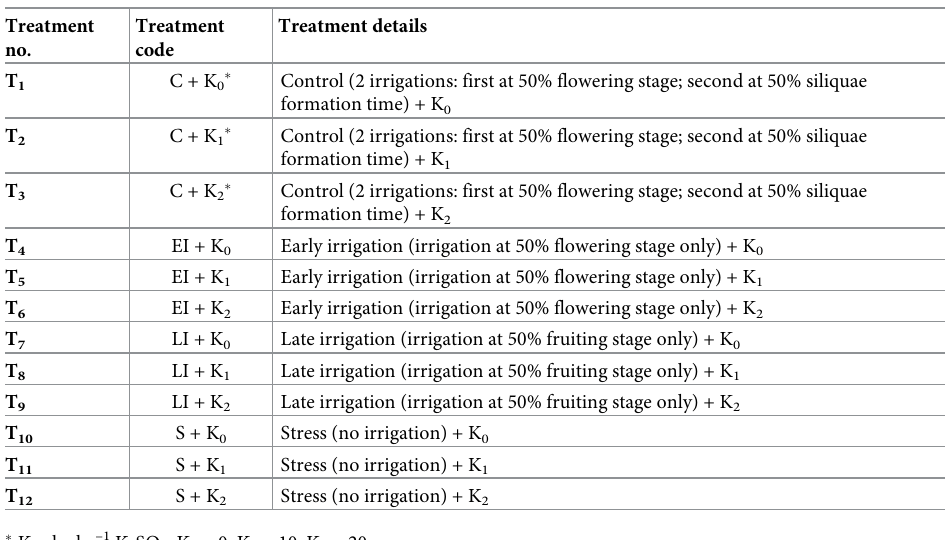
Table 1. The 12 treatments in the experiment. Treatment